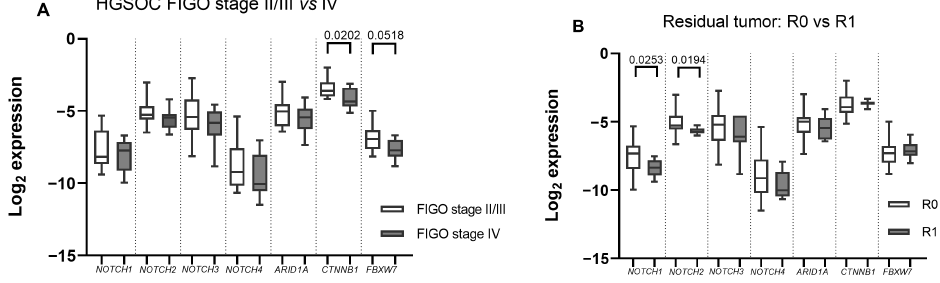
Figure 3. mRNA levels in high-grade serous ovarian cancer HGSOC tissues: ( A ) FIGO stage II/III (n = 20) vs. IV (n = 12); ( B ) with (R1) (n = 7) vs. without (R0) residual tumour (n = 25). Boxes indicate the log 2 normalized expression data. Whiskers denote minimum and maximum